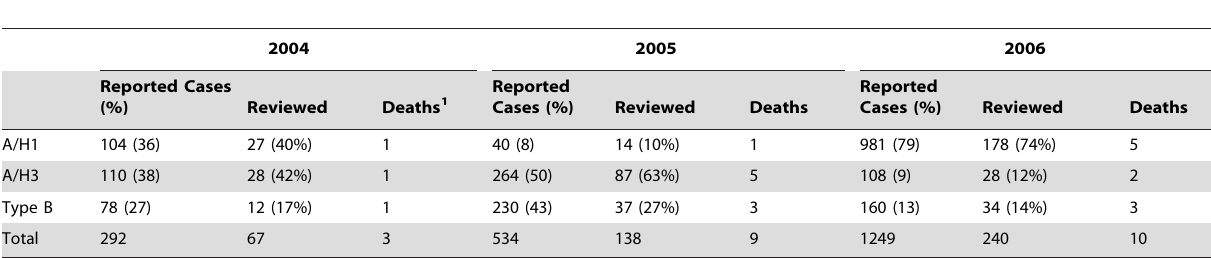
Table 1. Human influenza cases and deaths reported by National Avian Influenza Surveillance.